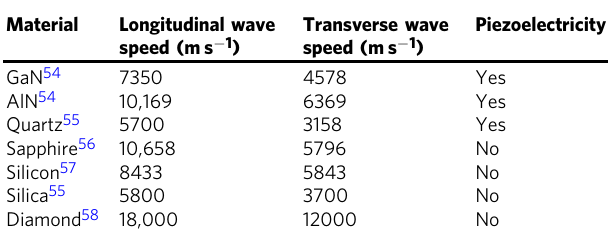
Table 1 Survey of acoustic waveguide and substrate materials